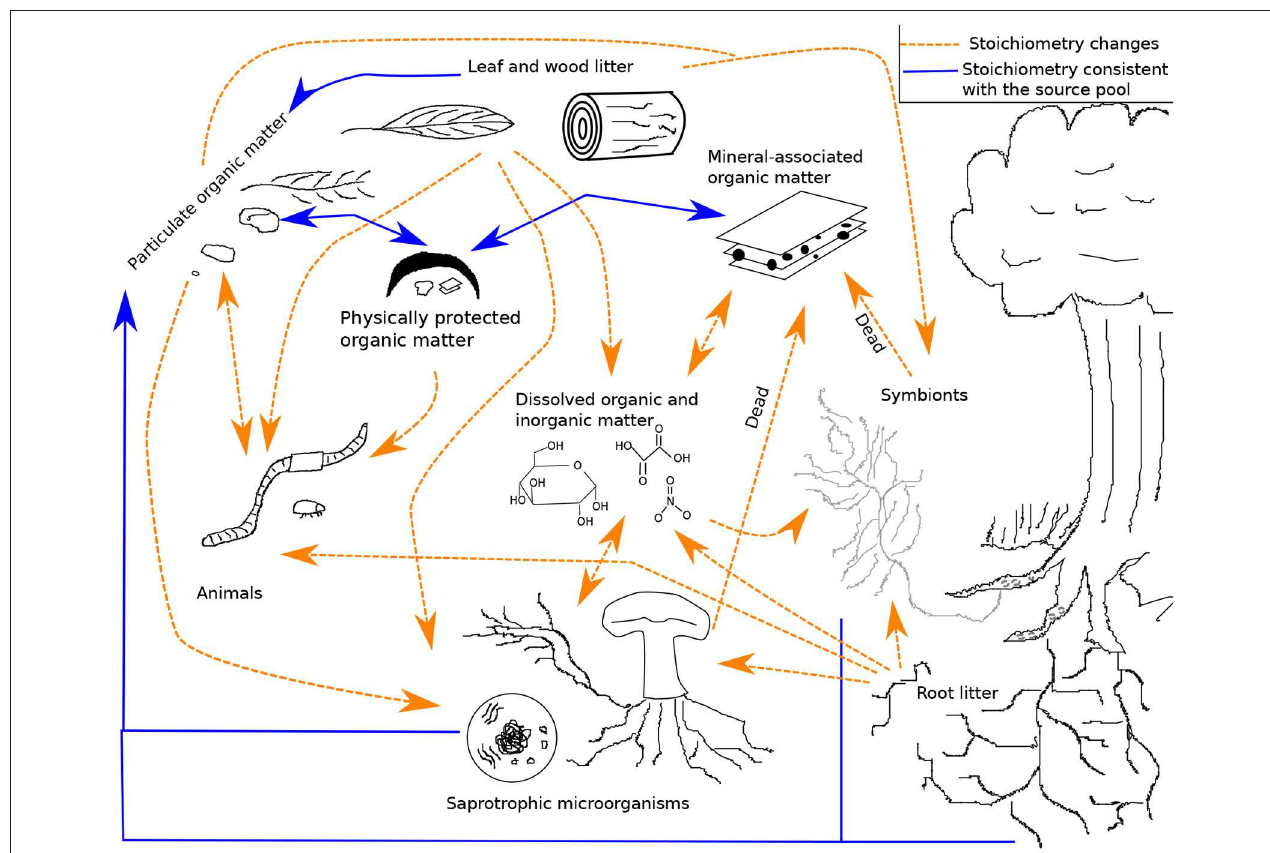
FIGURE 1 | A framework for the formation and loss of soil organic matter. Dashed orange arrows represent pathways with a stoichiometric bias, while solid blue arrows represent pathways with stoichiometry matching the source pools. This is not a model diagram and for readability does not show that most pools have variable chemical quality, multiple species, and multiple elements. The diagram also does not show inputs (root exudates, carbon to symbionts, nitrogen fixation, leaf, wood, and root litter) or outputs (leaching and respiration). See the model diagram in the supplemental ( Figure S1 ; Table S1 ).